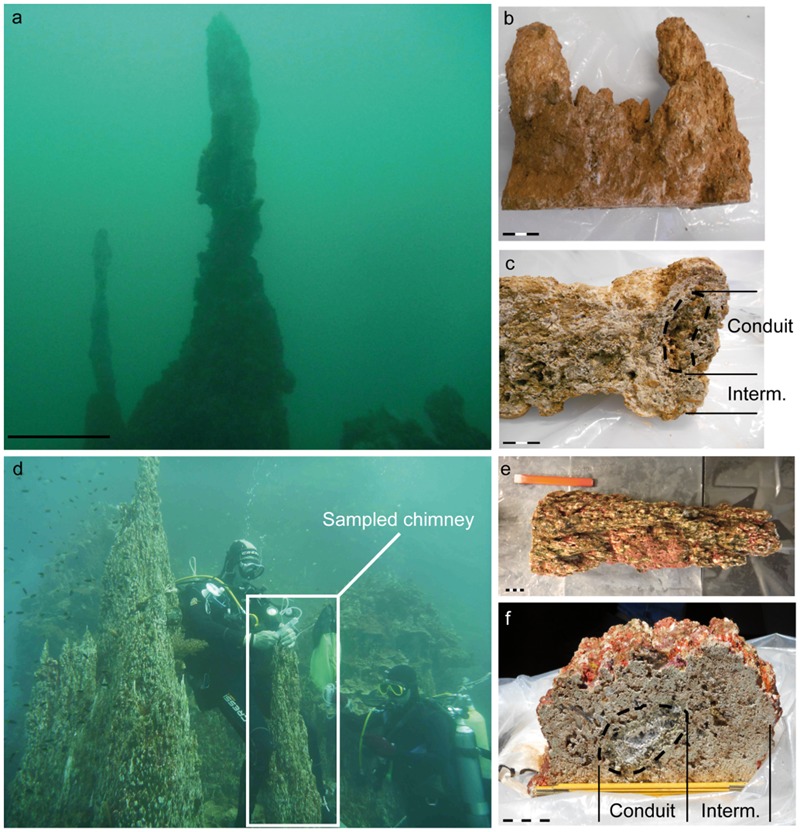
Photographs of the hydrothermal edifices from the Prony Bay (New Caledonia) characterized in the present study and sampled by scuba divers in 2011: ST09 (a–c), a quite young and active carbonated vent hosted at 50 mbsl on serpentinites, and ST07 (d–f) also called Roc Aiguille of Prony as the more massive carbonated chimneys of the lagoon, located at 25 mbsl. (a,d) are dive photographs of sites ST09 and ST07, respectively (modified from Quéméneur et al., 2014 and Postec et al., 2015). (b) (ST09) and (e) (ST07) are detailed photographs of the sampled chimneys, both actively discharging fluids, and (c) (ST09) and (f) (ST07) are transversal cuts with the localization of the active hydrothermal conduits. The venting structures were commonly organized in three parts. First, the inner conduit of a few centimeters in diameter corresponded to the location of the circulation of the reduced and alkaline fluids, deriving from serpentinization processes at depth. Secondly, the intermediate part (white to green color) constituted the main walls of the chimneys. Finally, the external part of the chimneys in direct contact with seawater were often colonized by macrofauna and corals, but not always, depending on the age of the chimney (a): scale bar = 1 m; (b,c,e,f): black scale bar = 1 cm.